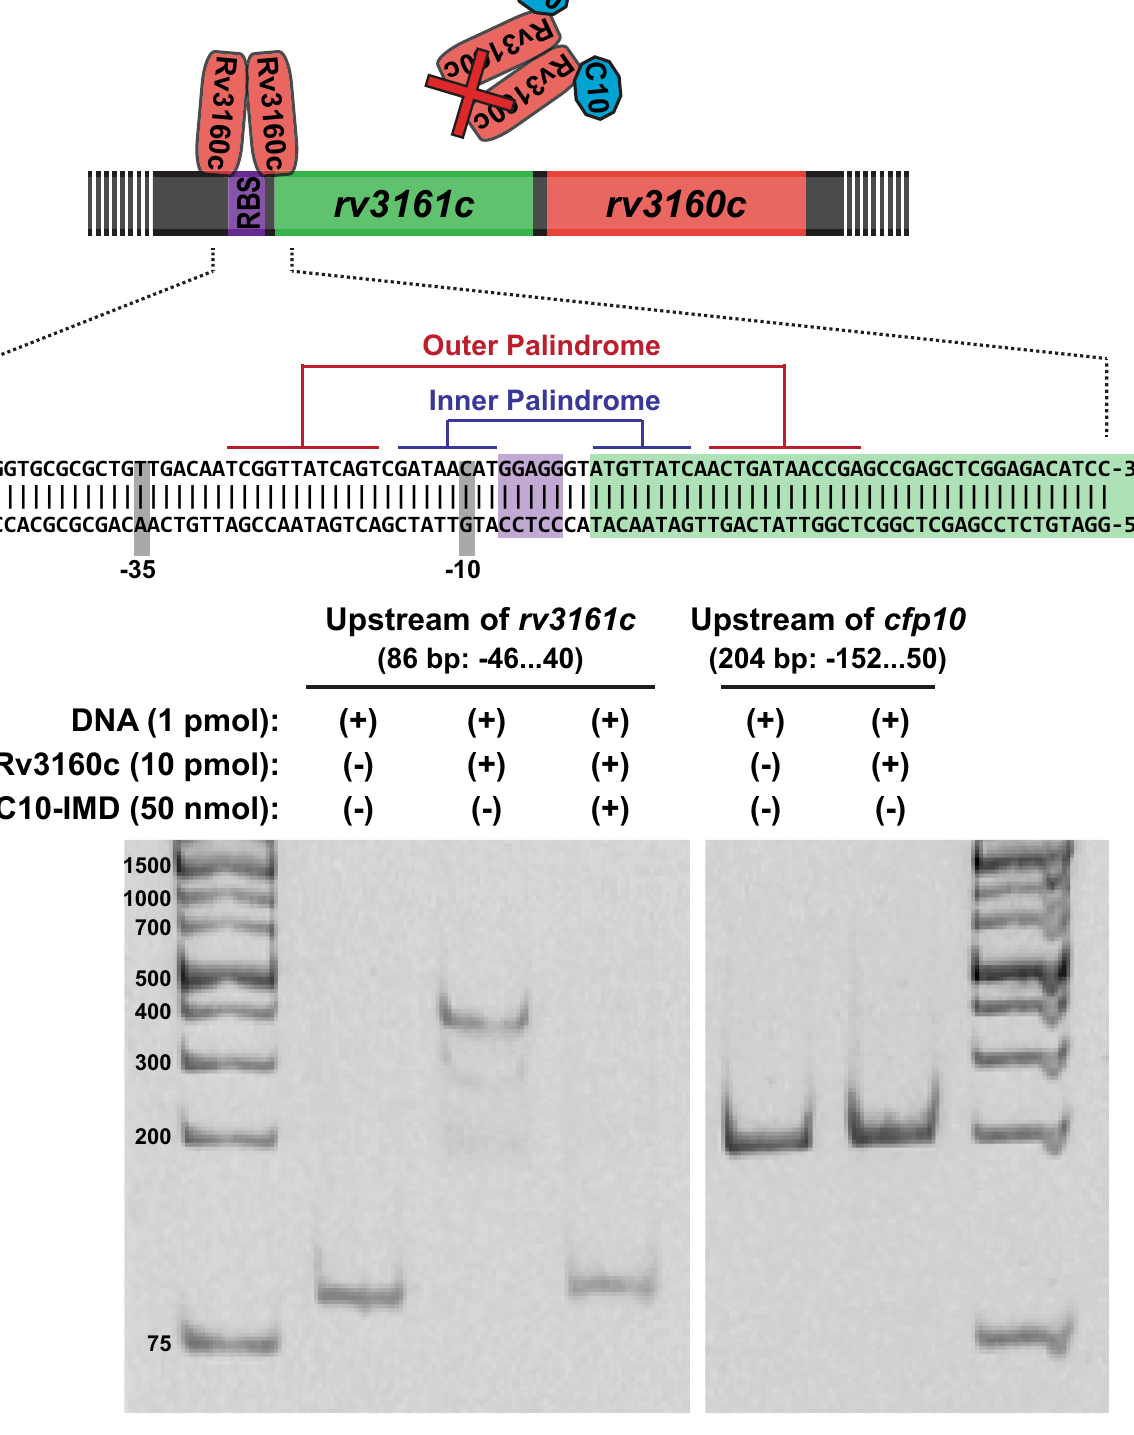
Figure 3. Binding of Rv3160c to the rv3160c-rv3161c operon is blocked by C10-IMD. ( A ) Schematic depicting model of the Rv3160c dimer binding to the palindromic sequence present in the rv3161c upstream fragment. ( B ) EMSA assay using an 86 bp rv3161c upstream fragment (1 pmol; lanes 1–3) and a 204 bp cfp10 upstream fragment as negative control fragment (1 pmol; lanes 4–5). Lane 1 and 5: no protein added. Lanes 2, 3 and